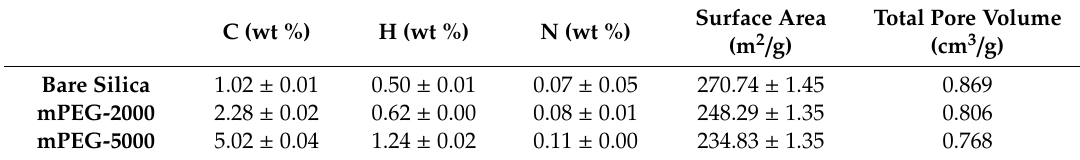
Table 1. Elemental composition and physical characteristics of bare and mPEG-grafted silica